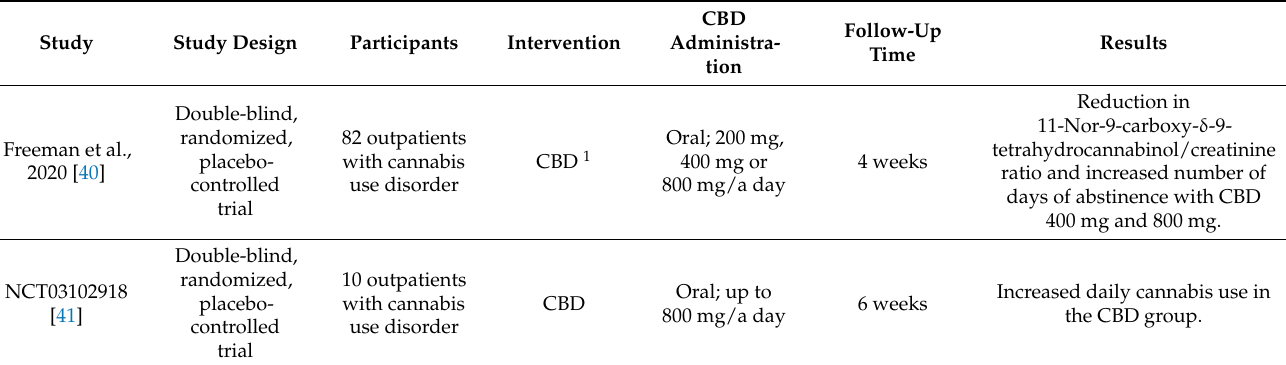
Table 3. Clinical trials testing Cannabidiol as a treatment for cannabis use